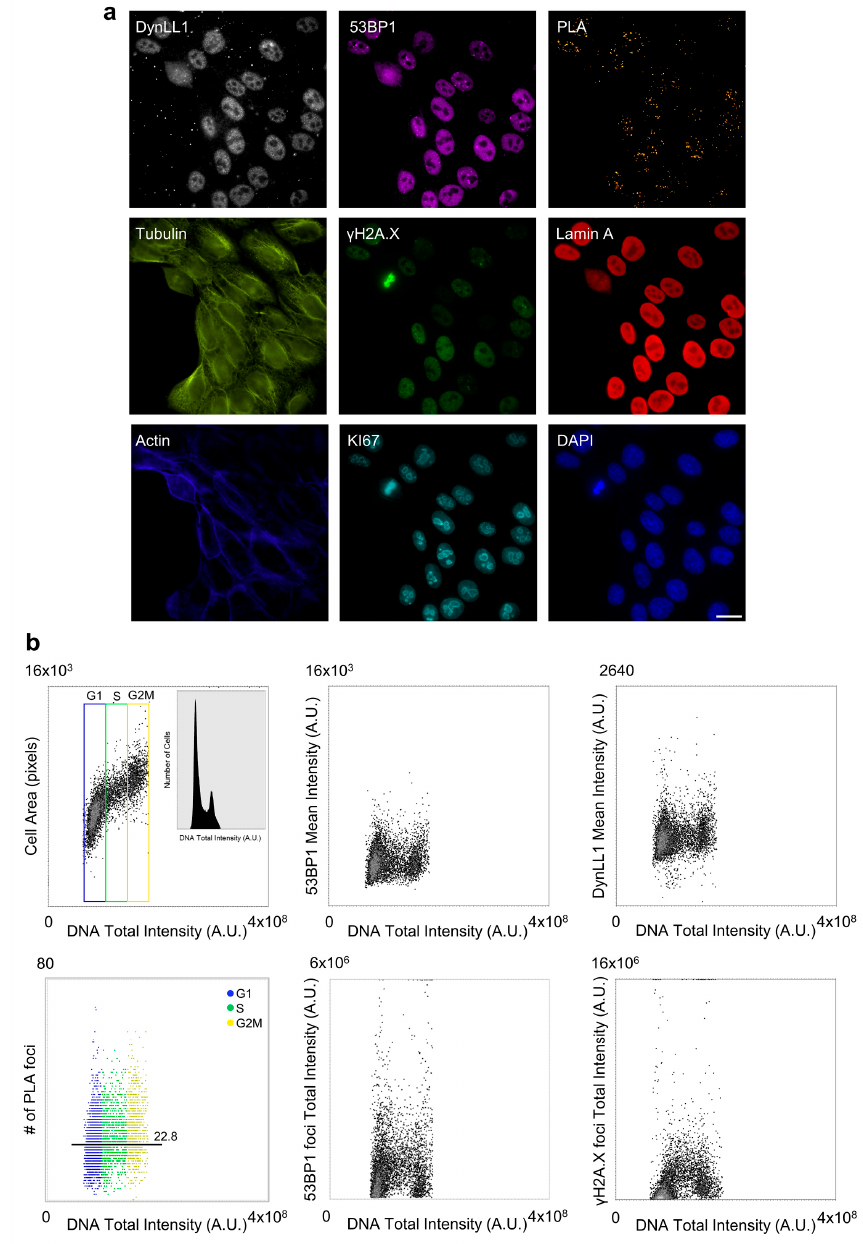
Figure 3. Image cytometry analysis of protein expression and protein–protein interaction (detected by Proximity Ligation Assay (PLA)) during the cell cycle. ( a ) Images of exponentially growing MCF10A cells were collected with a 60 × 1.4 Oil Immersion Objective according to the described automated widefield-acquisition procedure. Samples were stained for the detection of DynLL1, 53BP1, 53BP1- DynLL1 PLA, Tubulin, γ H2A.X, Lamin A, Actin, KI67, and DNA (DAPI). Scale bar: 20 µ m. ( b ) The dot plots report the bivariate distribution of DNA content ( X -axis) versus ( Y -axis) (i) cell area and number of cells (n = 5156) (histogram in the box) to detect the cell-cycle distribution according to the DNA content—G1 (blue), S (green), and G2M (yellow); (ii) mean intensity per pixel per cell of 53BP1 and DynLL1 to estimate the protein content during the cell cycle; (iii) total intensity of 53BP1 and γ H2A.X foci to measure the DNA Damage in relation to the cell-cycle position; and (iv) number of interaction spots detected by a PLA assay between 53BP1 and DynLL1 during the cell